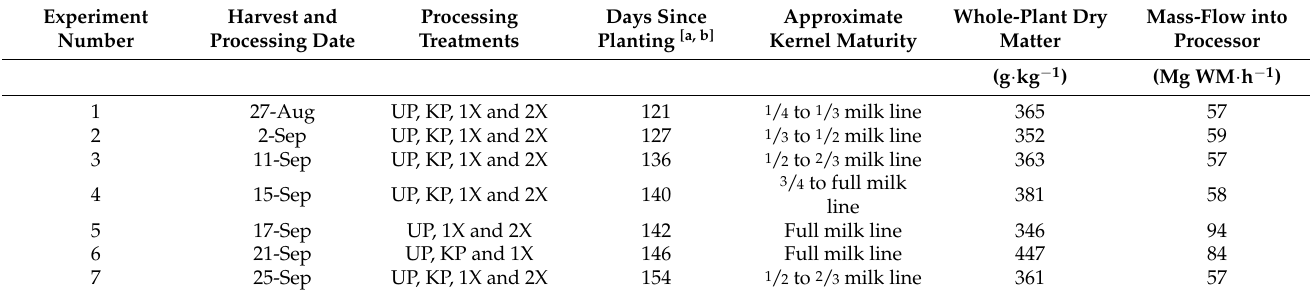
Table 1. Details of experiments conducted during 2020 using whole-plant